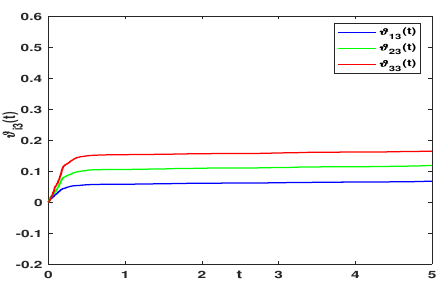
Figure 9. The adaptive laws ϑ i 3 ( t )